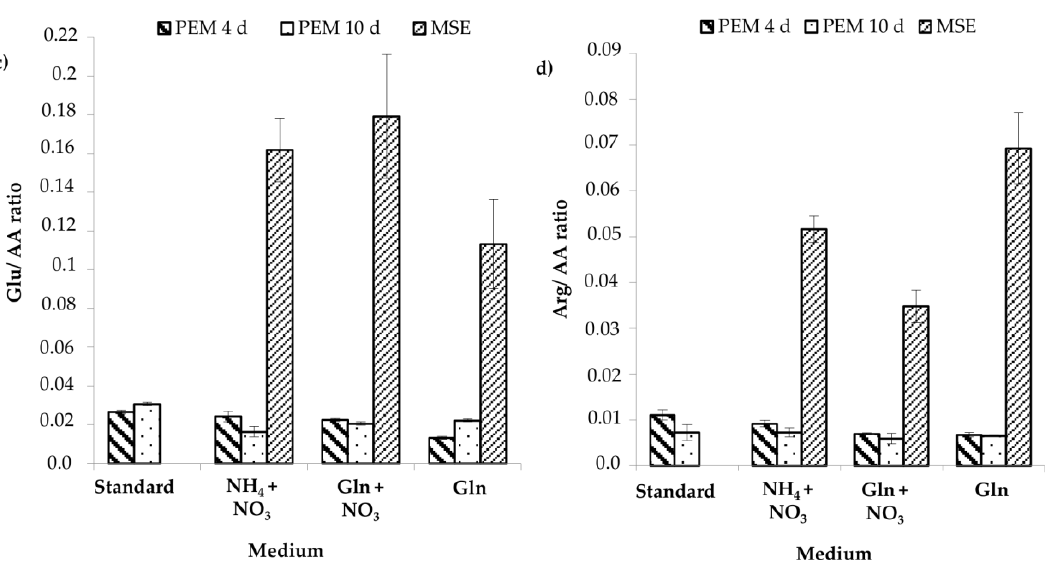
Figure 9. Ammonium and amino acid contents of PEMs four and ten days after transfer to standard medium, NH 4 + NO 3, medium, Gln + NO 3 medium and Gln medium and mature somatic embryos (MSE) after six weeks on the corresponding maturation media. ( a ) ammonium contents per g FW; ( b ) L - glutamine content expressed as the ratio of L-glutamine: total amino acid content (Gln/AA); ( c ) L- glutamate content expressed as the ratio of L-glutamate: total amino acid content (Glu/AA); ( d ) L- arginine content expressed as the ratio of L-arginine: total amino acid content (Arg/AA). Bars indicate standard errors.